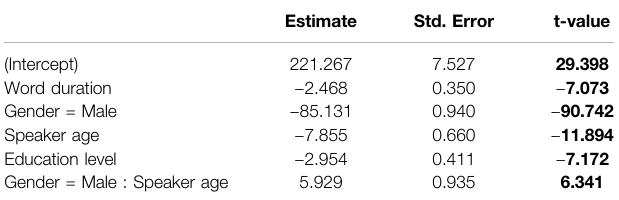
TABLE 1 | Linear mixed-effects regression summary table for F0. Absolute t-values larger than 2 are regarded to indicate signi fi cance and are highlighted in